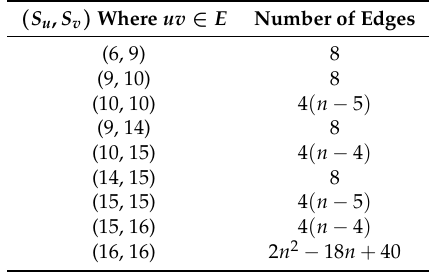
Table 4. Edge partition of SL n on the basis of degree sum of neighbors of end vertices of each